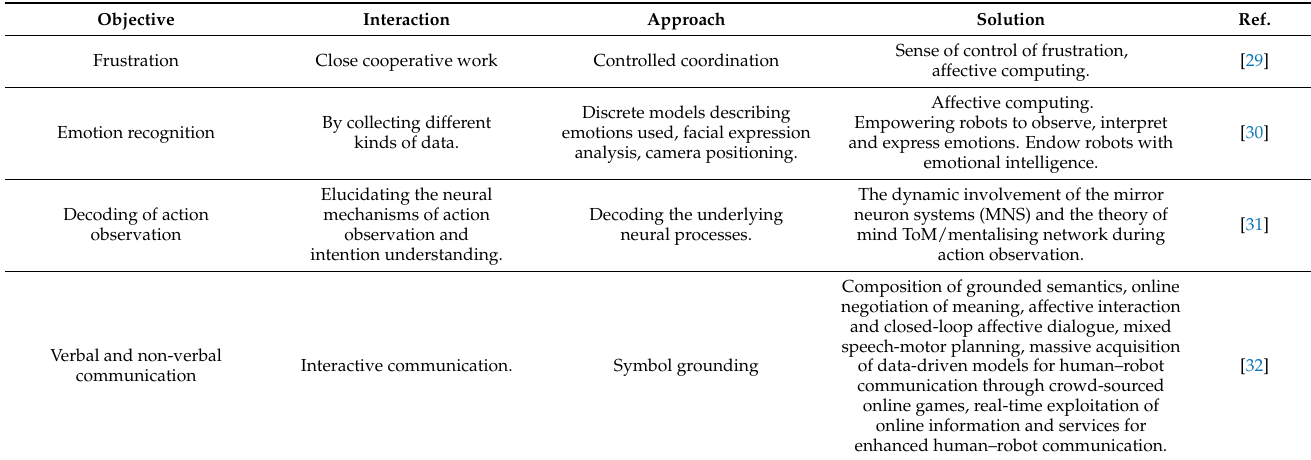
Table 2. Interfering aspects in human–robot